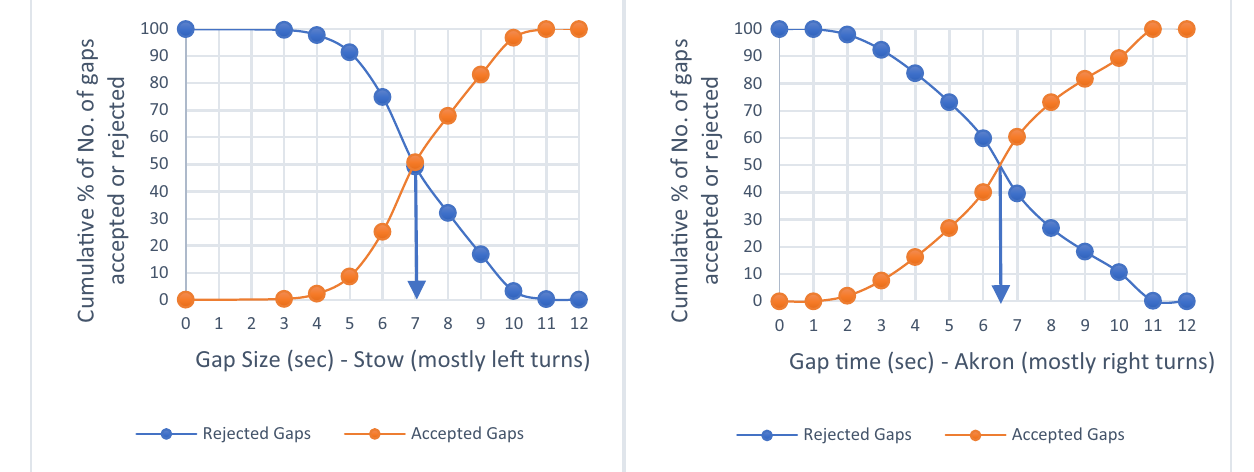
Figure 17: Critical gap estimate using Ra ff ’ s method.